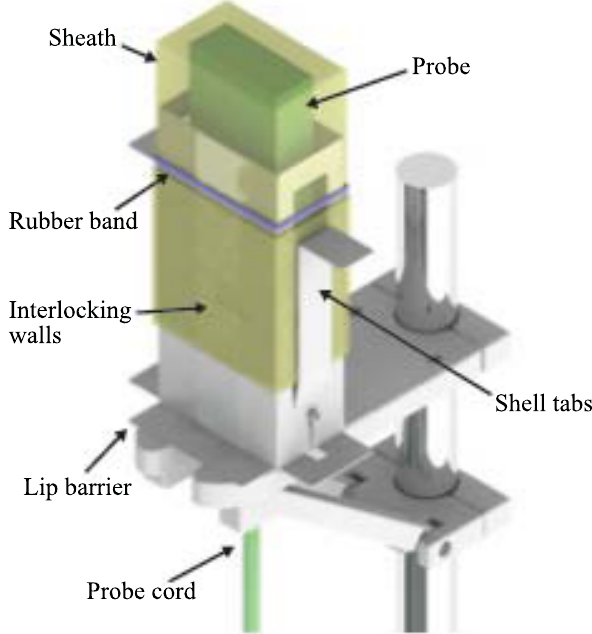
Figure 5. Rendering of the final concept showing sheath shell and integrated probe holder engaged by the sheath